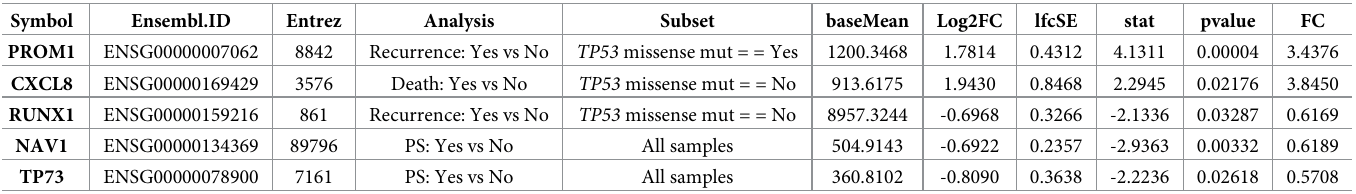
Table 2. Concordant DESeq2 results of the gene expression analysis in the validation HGSOC cohort. Symbol